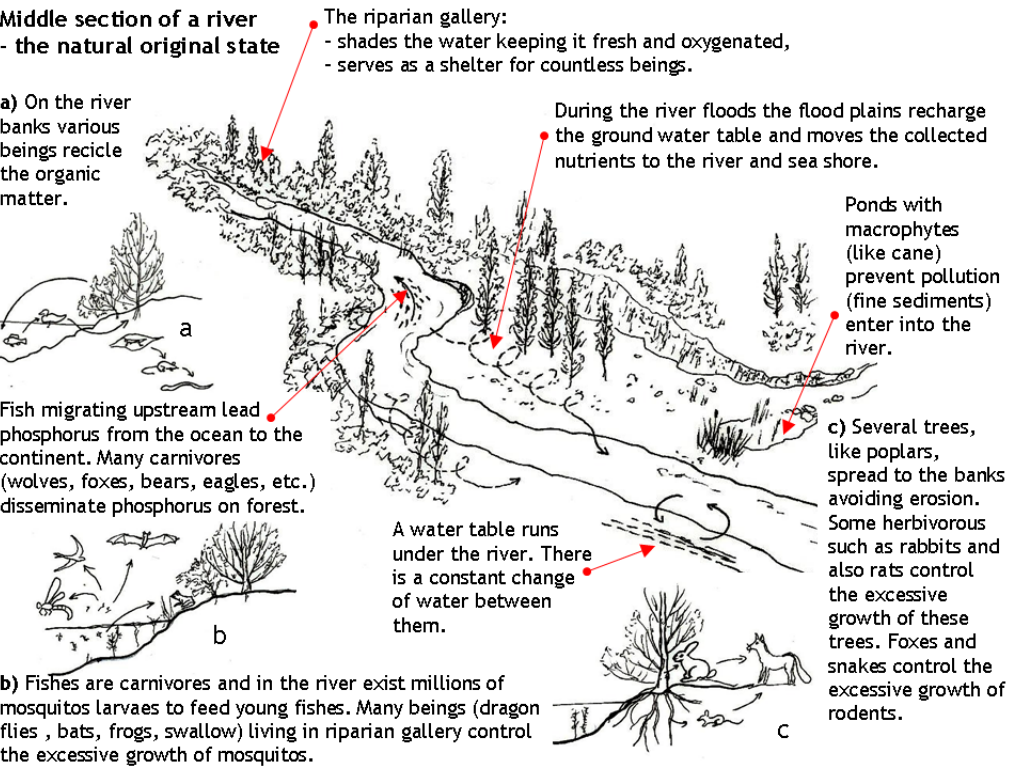
Figure 3a: The detail B of the drawing 2 a: The natural river banks with the fauna and flora. The processes shown in the detailed small draw- ings “a”, “b”, and “c”. In rivers there exists a food web interaction between aquatic and land organisms [10].